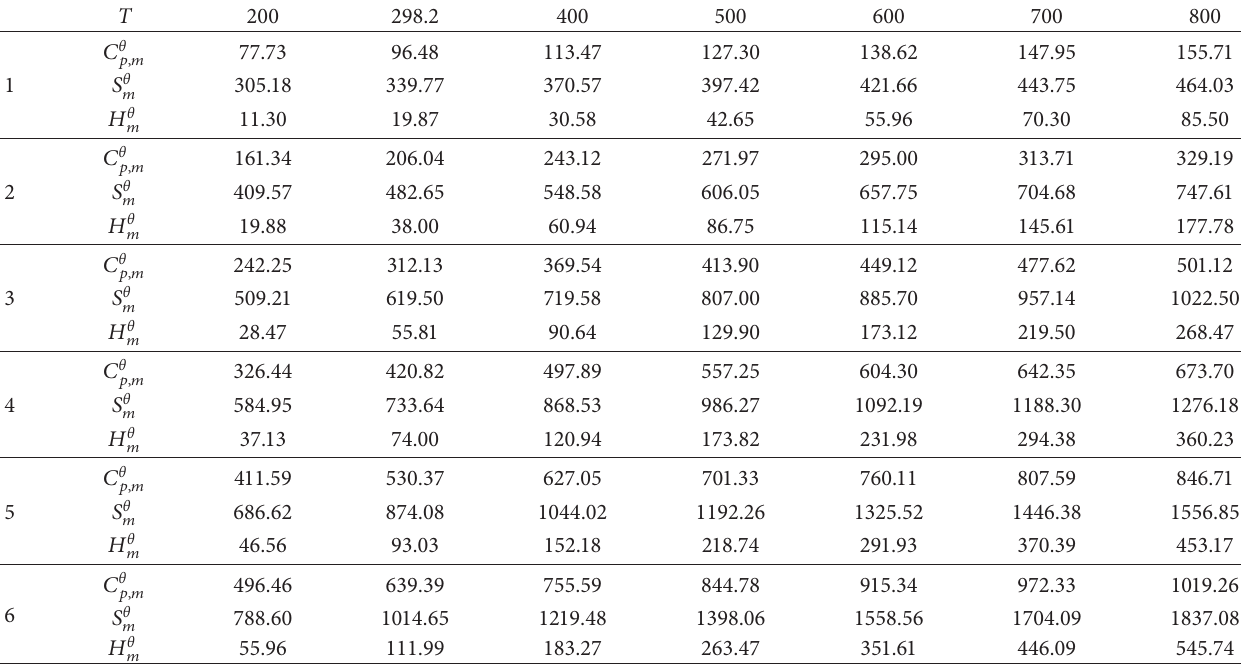
Table 4: Thermodynamic properties for the most stable clusters (CH T 200 298.2 400 500 600